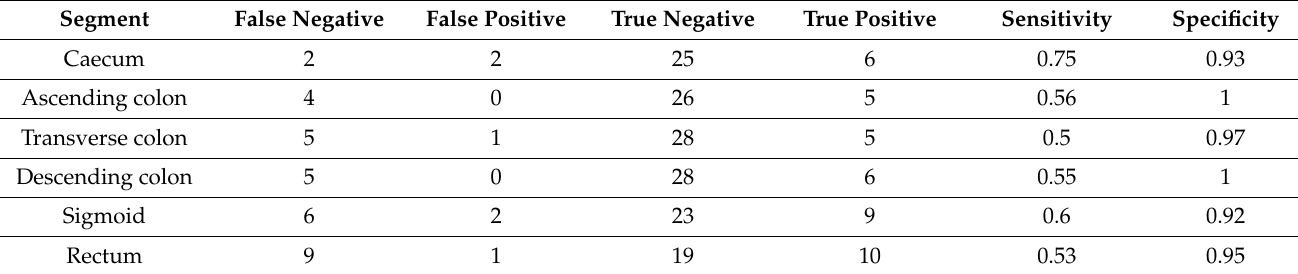
Table 2. The results of comparison MRE to colonoscopy.